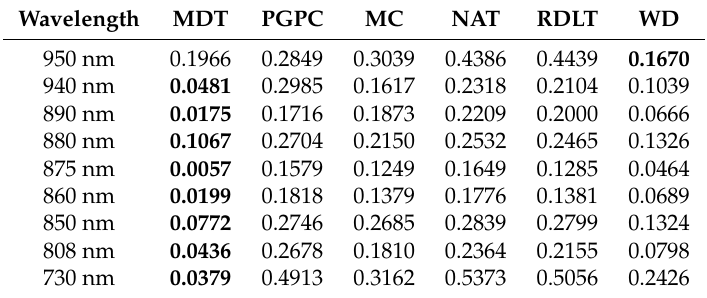
Table 3. The false positive ratio FPR [%] calculated for all compared methods for the best parameters dictated by the ACC